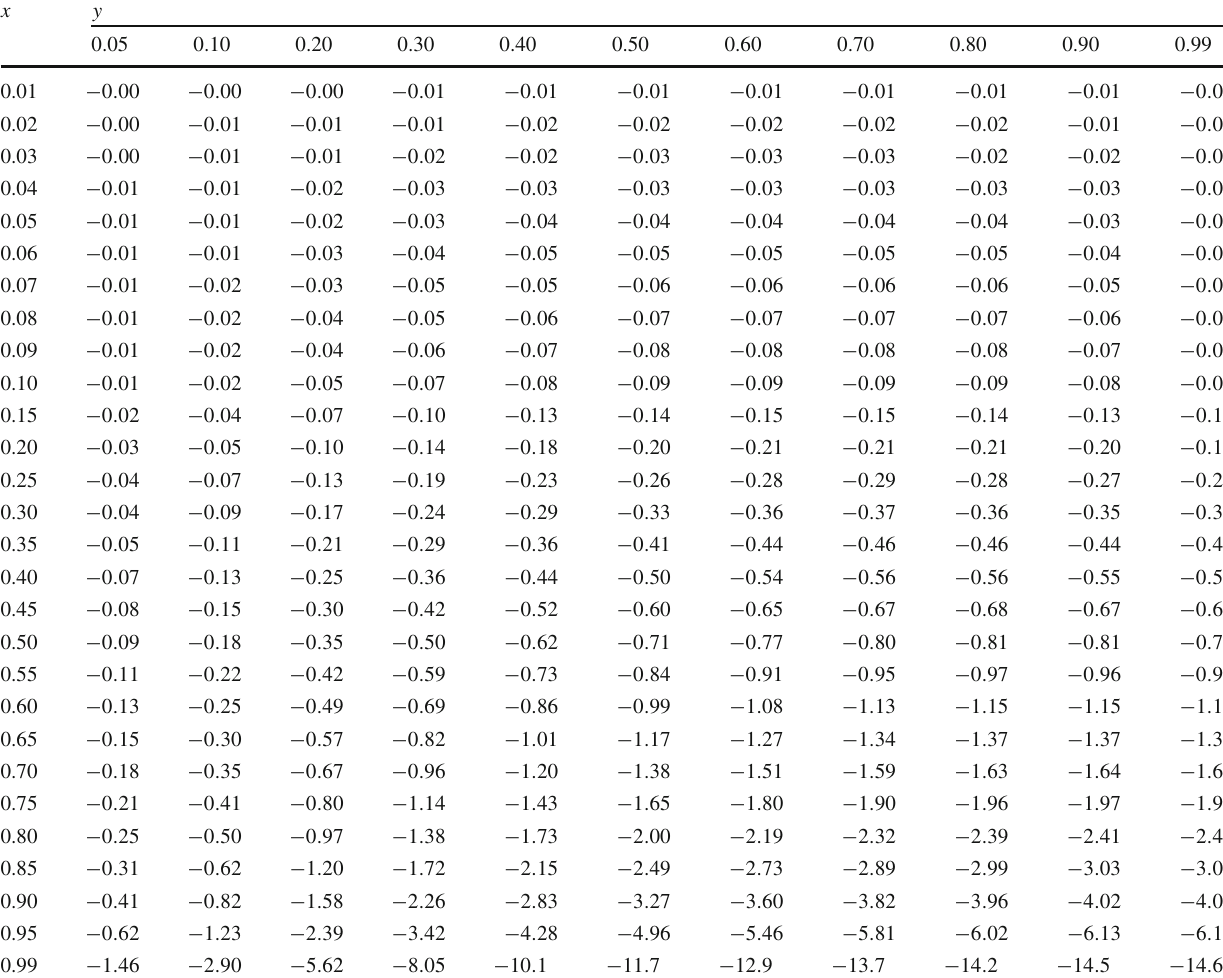
Table 6 The 1 γ IR correction δ 1 γ IR ( x , y ) at NLO for the process Σ 0 → Λ e + e − to be multiplied by 10 − 4 . It is sufficient to show the results for positive values of y only since these corrections are